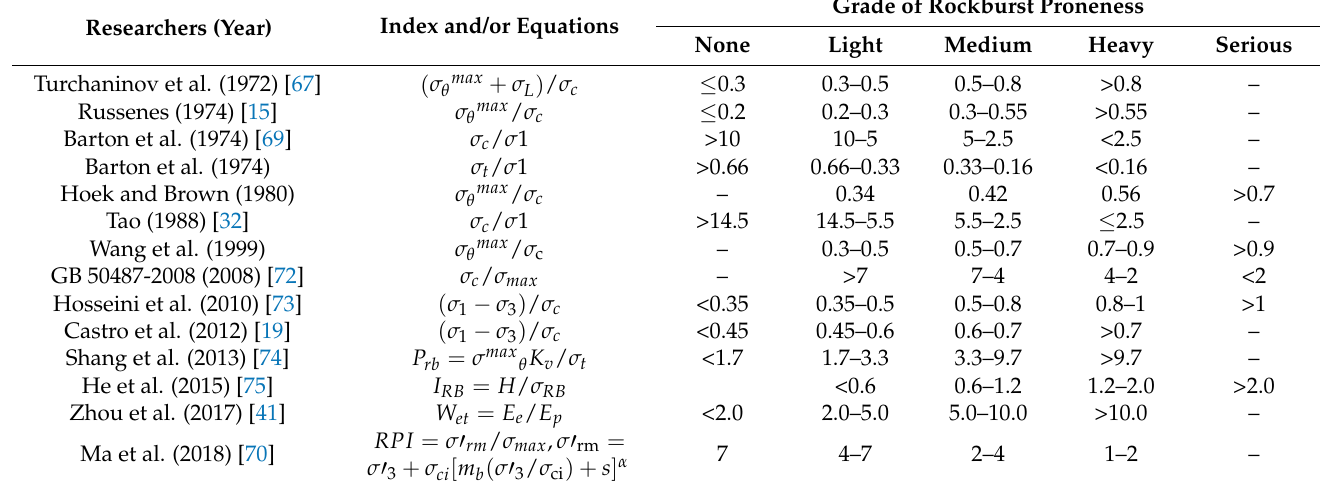
Table 4. Rockburst strength criteria